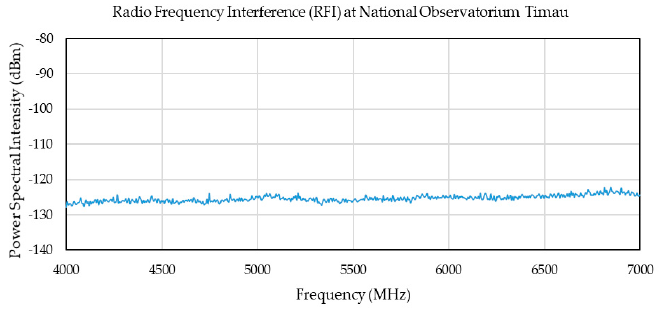
Figure 9. Results of radio frequency survey at low frequencies between 2000 and 3000 MHz.